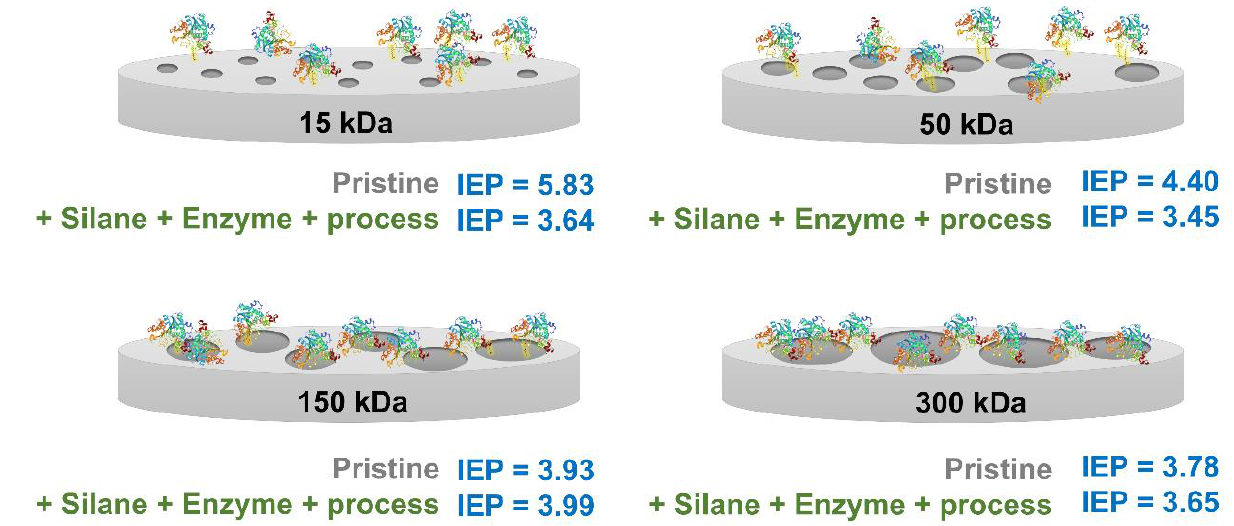
Figure 6. Relation between surface morphology (MWCOs) and possible location of grafting molecules and enzymes and the changes in isoelectric point (IEP) of the surface.